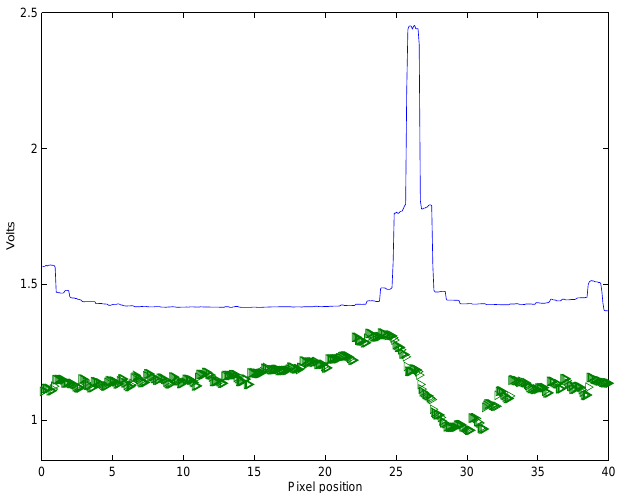
Figure 5 . Response of the WTA network to the ON-edge of a bar moving from left to right at an on-chip speed of 31mm/s. The top trace represents the scanned WTA output of the 40 pixels, while the bottom trace represents the outputs of the adaptive